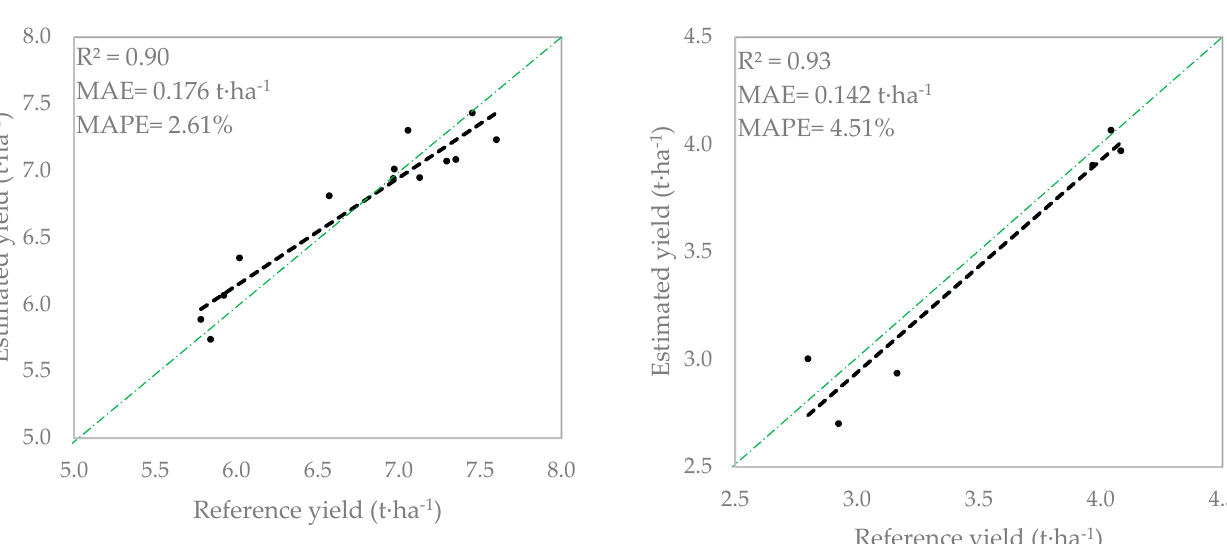
Figure 7. Validation at parcel level of the JSendra fields ( left ) and Bomba fields ( right ).